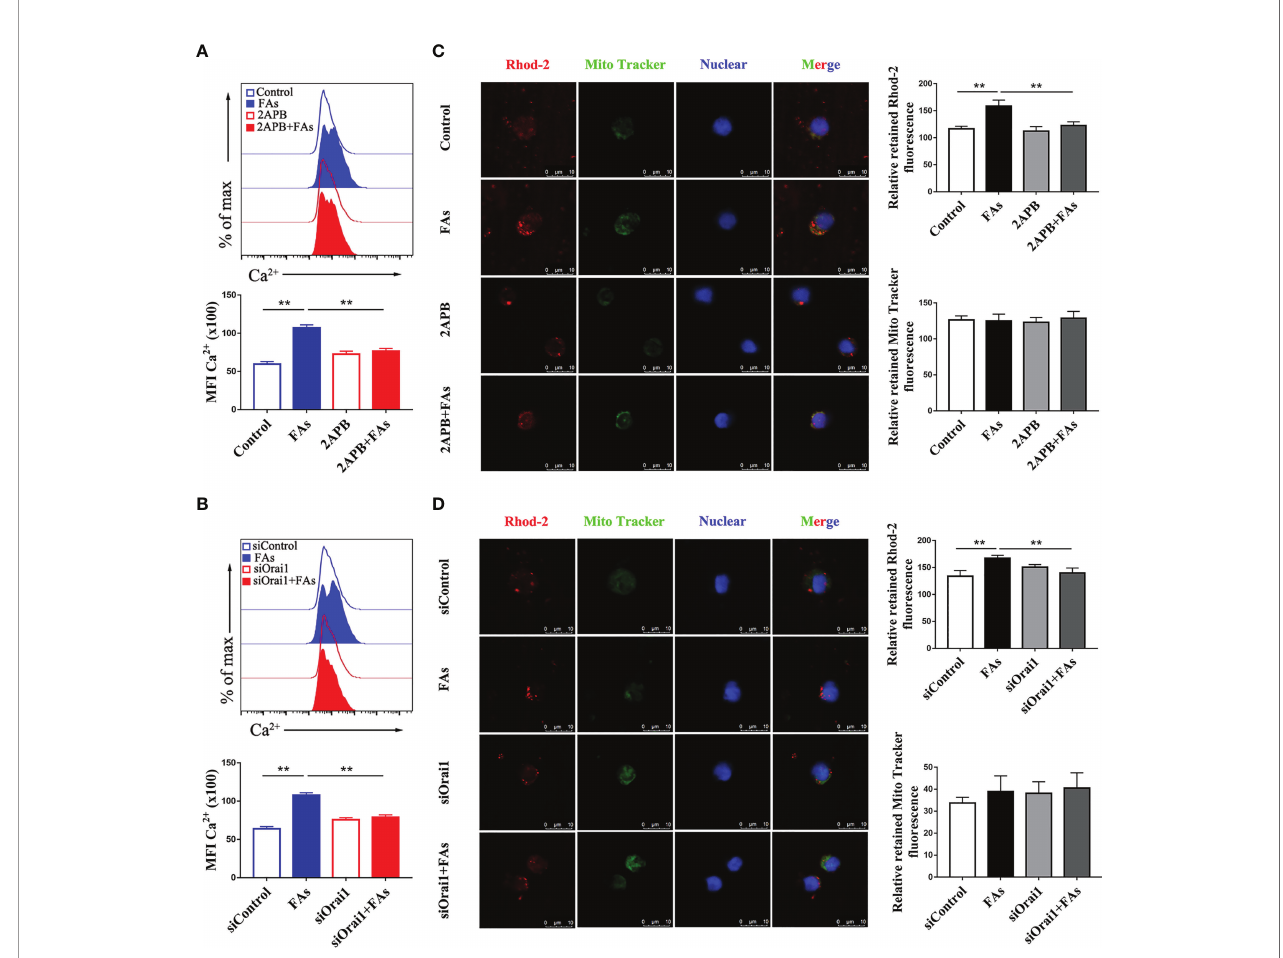
FIGURE 6 | Inhibition or silencing of ORAI1 relieved FAs-induce increased level of intracellular Ca 2+ and mitochondrial Ca 2+ in CD4 + T cells. CD4 + T cells were sorted from spleens from 1-d old calves and stimulated with 2APB or siORAI1 before FAs treatment with 12 h (A) Staining of intracellular Ca 2+ use Fluo-3A in stimulated with 2APB (n = 4 per group). (B) Staining of intracellular Ca 2+ use Fluo-3A in stimulated with siORAI1 (n = 4 per group). (C) Staining of mitochondrial Ca 2+ use Rhod-2 in stimulated with 2APB (n = 3 per group; 3 random fi elds per group; scale bars, 10 m m). (D) Staining of mitochondrial Ca 2+ use Rhod-2 in stimulated with siORAI1(n = 3 per group; 3 random fi elds per group; scale bars, 10 m m). The data of the control were used to normalize other treatments. Comparisons among groups were calculated using a one-way ANOVA with a Duncan correction. The data presented are the mean ± SEM, **P ≤ 0.01 indicate differences from control or FAs